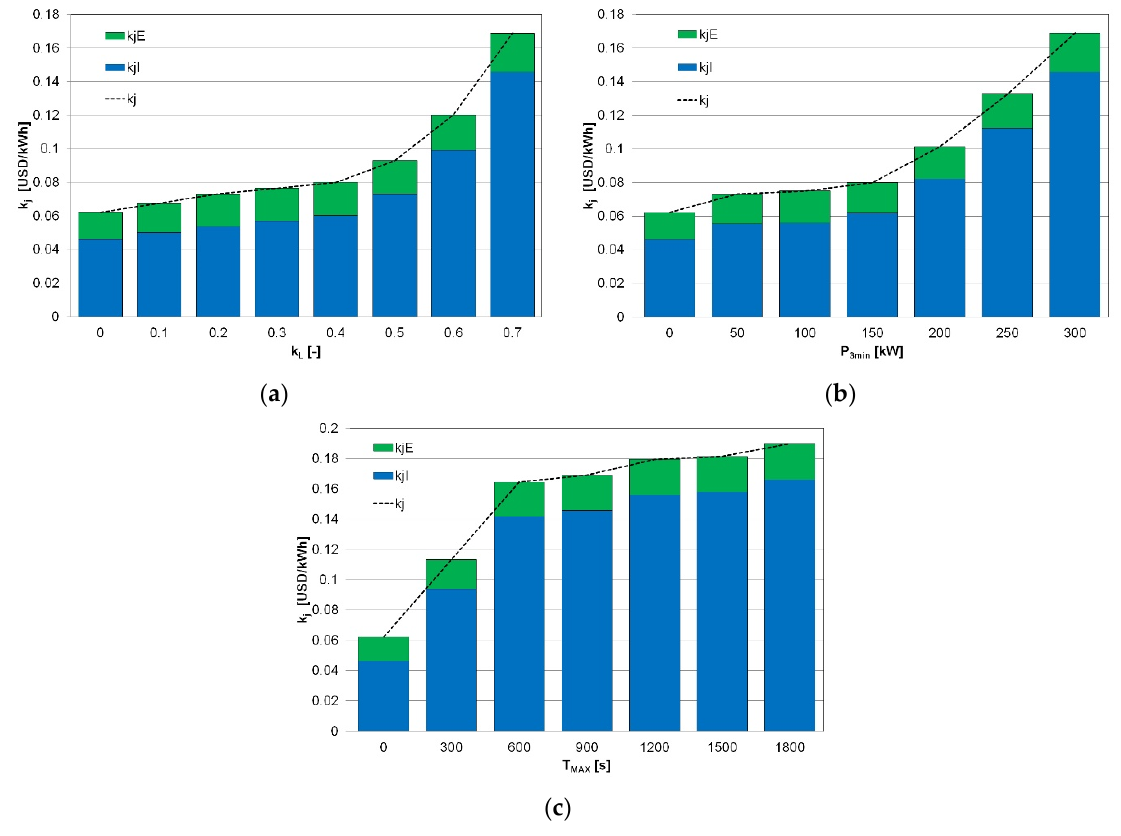
Figure 8. Values of the discounted unit cost of energy generation in the optimised WPP-FESS system for the year 2011 as a function of: ( a ) index of elimination of acceptable interruptions k L (P 3MIN = 300 kW, T MAX = 900 s); ( b ) P 3MIN power (T MAX = 600 s, k L = 0.7), ( c ) time T MAX (P 3MIN = 300 kW, k L = 0.7).